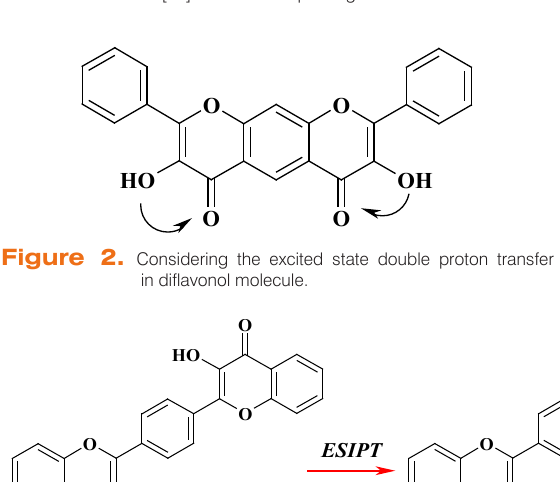
Figure 1. molecule.Schematic illustration of the principles of intensometric (top, simulated spectra) and ratiometric (bottom, our own data [22 ] fluorescence probing.